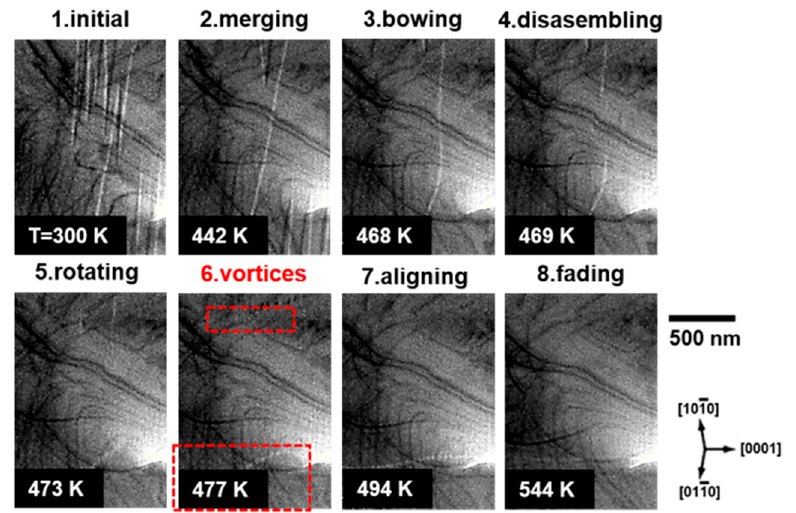
Figure 3. Sequential BF-TEM images of the Z-type hexagonal ferrite via in situ heating.